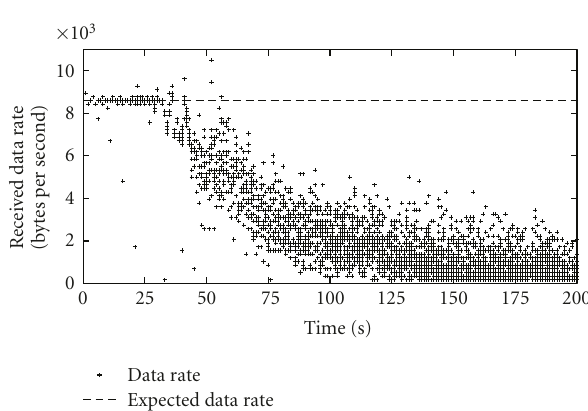
Figure 12: Node placement on practical experiments.